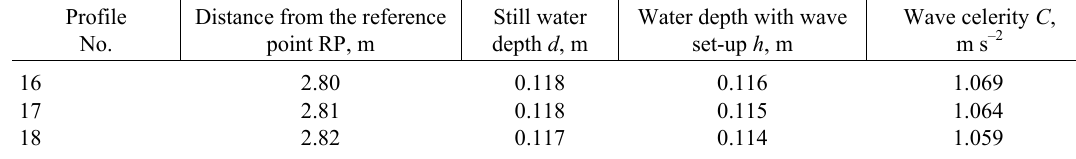
Table 2. Location of measuring profiles and corresponding wave